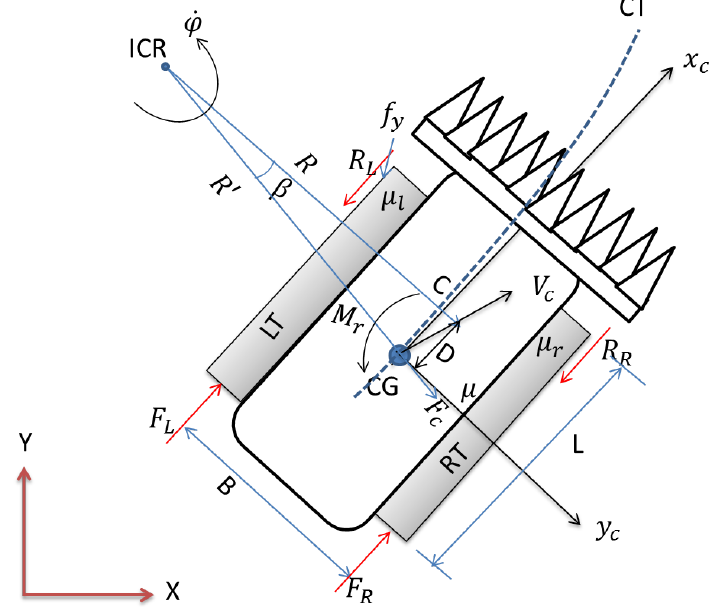
Figure 3. Free body diagram of the tracked combine harvester dynamic model.